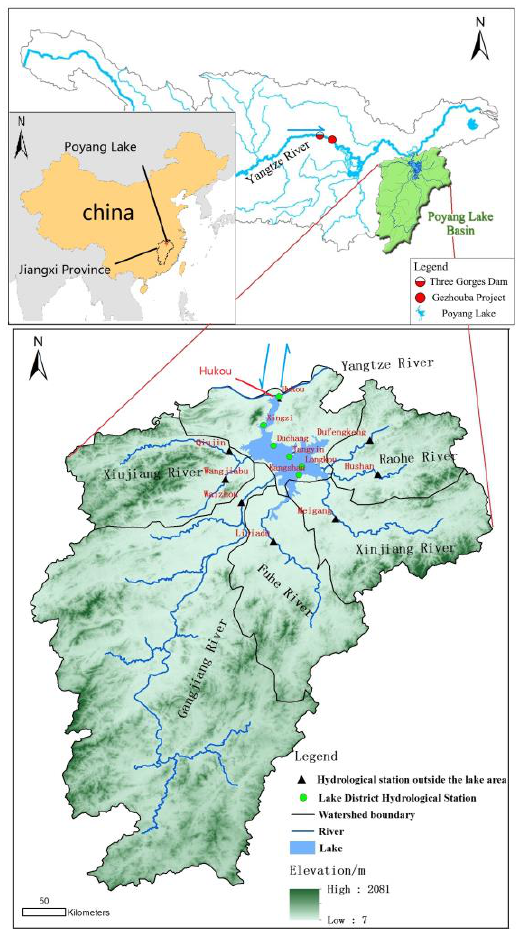
Figure 1. Study area. Upper image: Blue arrows indicate the flow direction in the Yangtze River. Lower image: Blue arrows indicate the flow direction in the water exchange channel between Poyang Lake and the Yangtze.